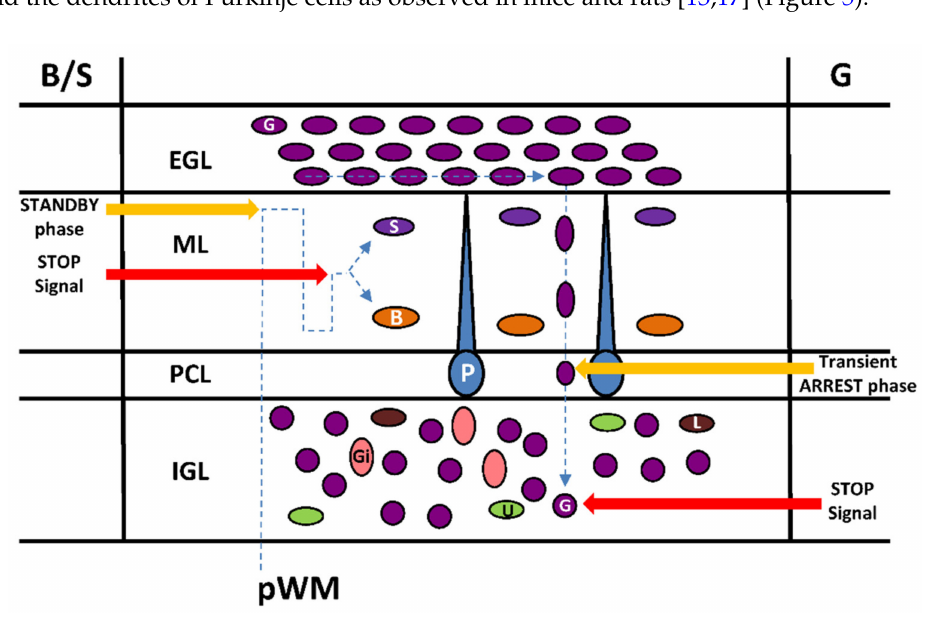
Figure 5. Transient arrest phase, standby phase and stop signals for interneurons during migration in the postnatal cerebellar cortex. pWM, prospective white matter; EGL, external granular layer; ML, molecular layer; PCL, Purkinje cell layer; IGL, internal granular layer; Gi, Golgi cell; U, unipolar brush cell; G, granule cell; L, Lugaro cell; P, Purkinje cell; B, basket cell; S, stellate